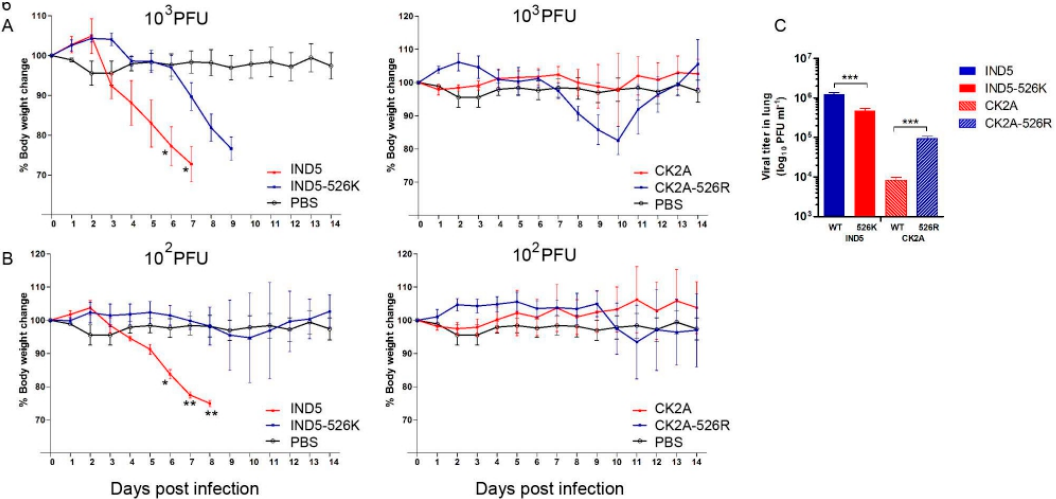
Figure 6. Evaluation of H5N1 virus infection and replication in mice. Groups of four or six BALB/c mice, aged 4–6 weeks, were intranasally inoculated with 10 3 ( A ) or 10 2 ( B ) PFU of virus containing wild type IND5 or CK2A, or the 526K (IND5-526K) or 526R (CK2A-526R) mutant viruses, in 25ul PBS. Body weight and survival were monitored daily for 14 days post infection. Results of infection with high doses of virus (10 4 , 10 5 and 10 6 PFU) are shown in the Supplementary Materials (Figure S1). The MLD 50 was calculated by the method of Reed and Muench [30]. ( C ) Replication efficiency of viruses in lung tissues of infected mice. To determine virus titers in mouse lung tissues, groups of three mice were infected with 10 3 PFU of the respective viruses described above and then euthanized at 72 h post infection, with lung tissues from each mouse being collected and homogenized for virus titration by plaque assay using MDCK cells. Error bars represent standard deviation from virus-infected mice